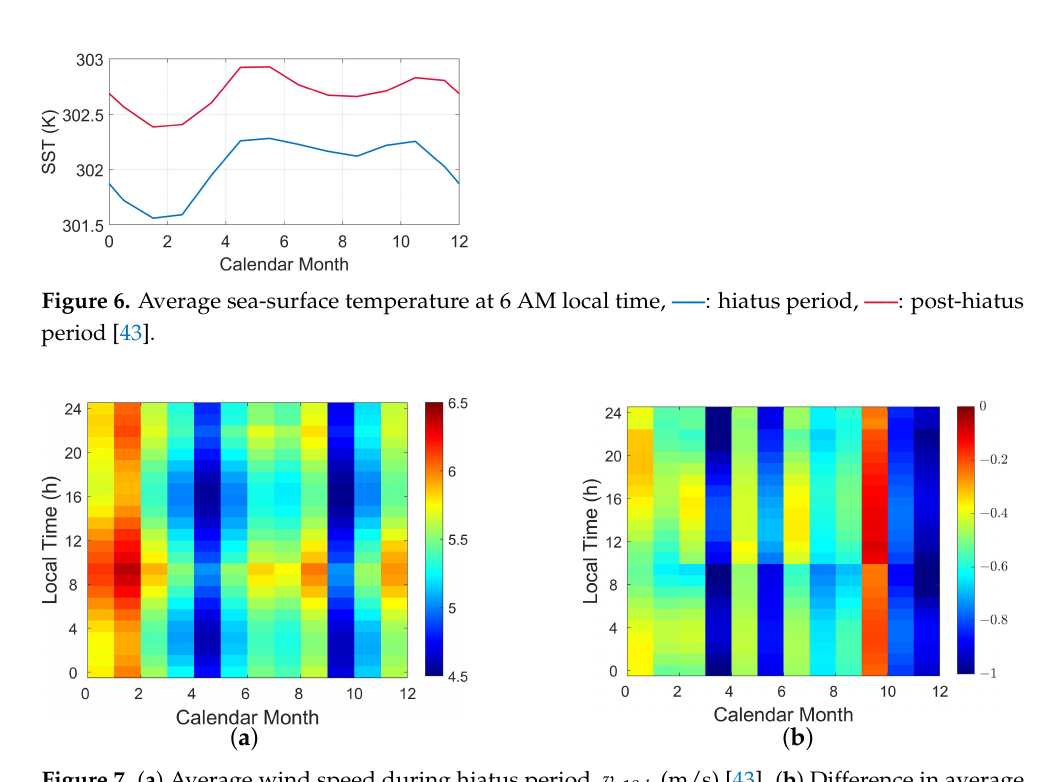
Figure 7. ( a ) Average wind speed during hiatus period, v a 10, h (m/s) [43]. ( b ) Difference in average wind speed between post-hiatus and hiatus periods [43].